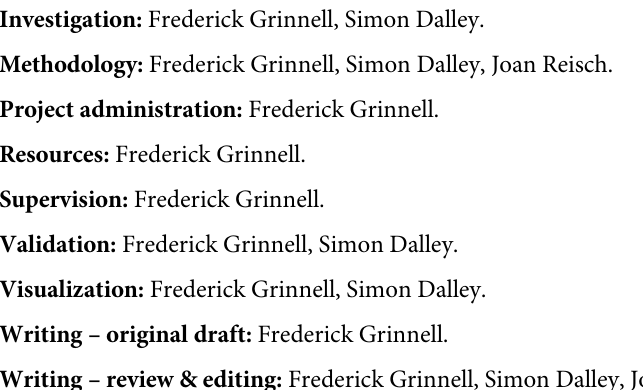
S1 Data set. Excel dataset showing all of the survey questions and answers for 2018/19